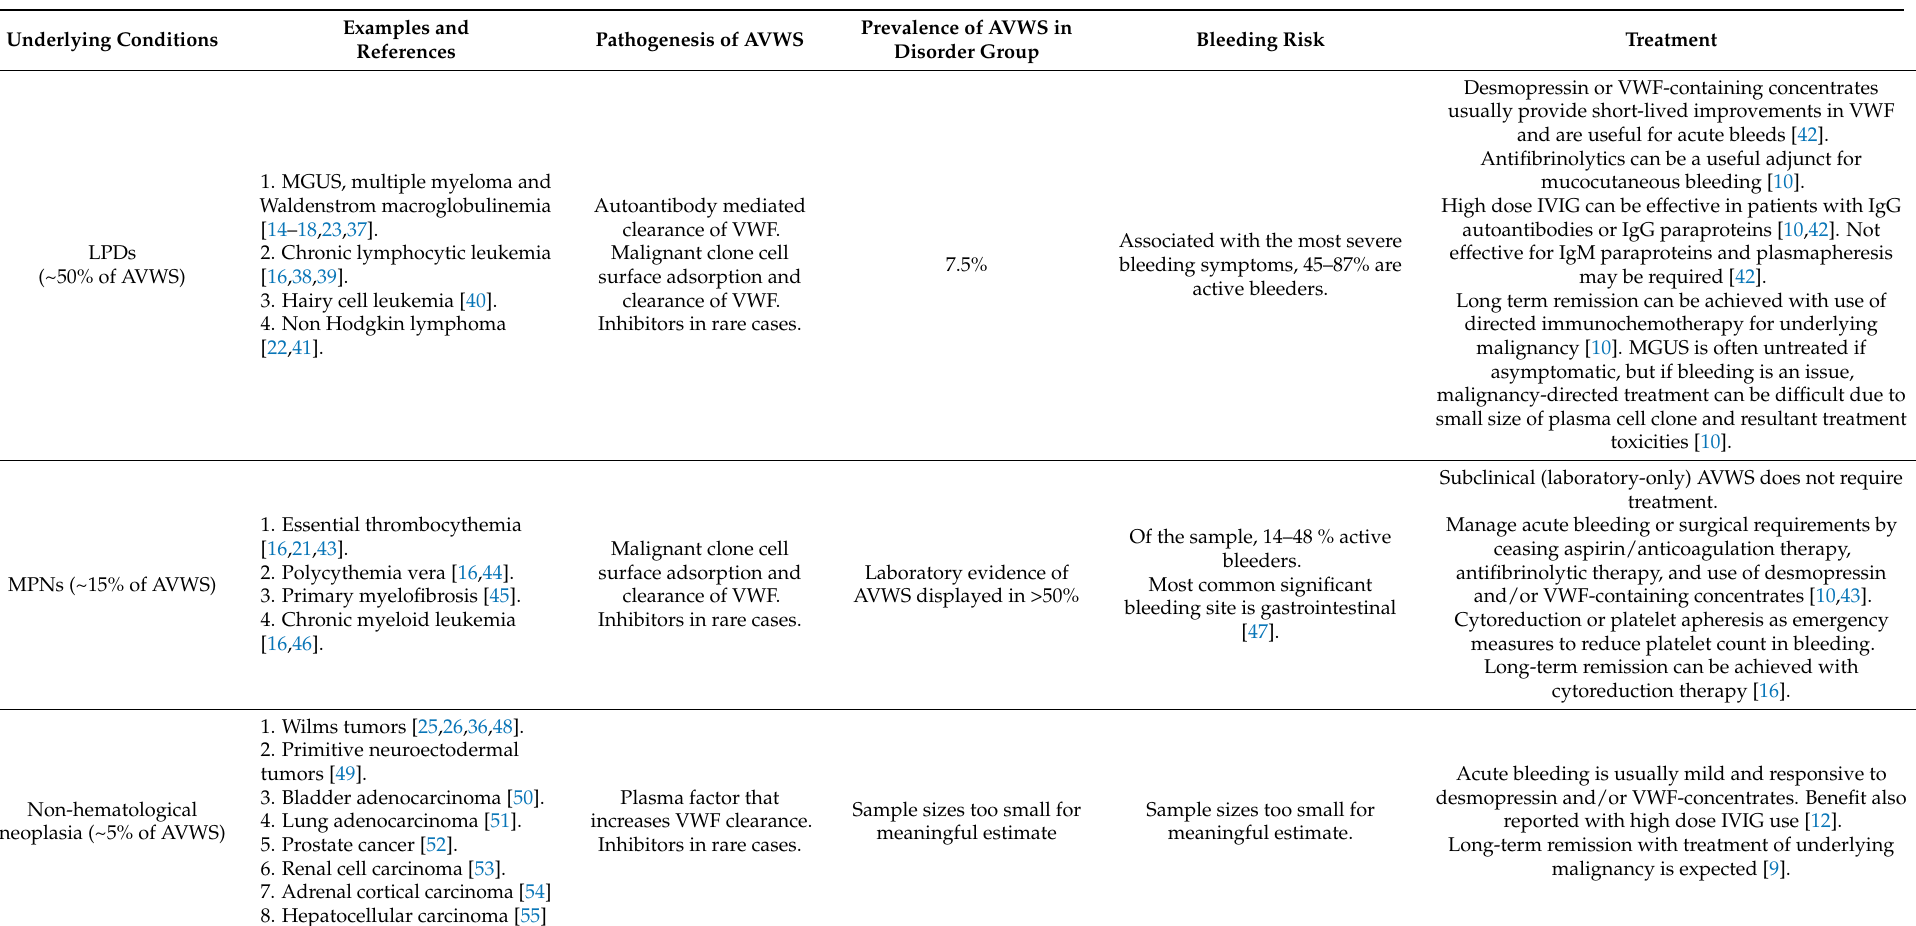
Table 2. Malignancies associated with acquired von Willebrand syndrome